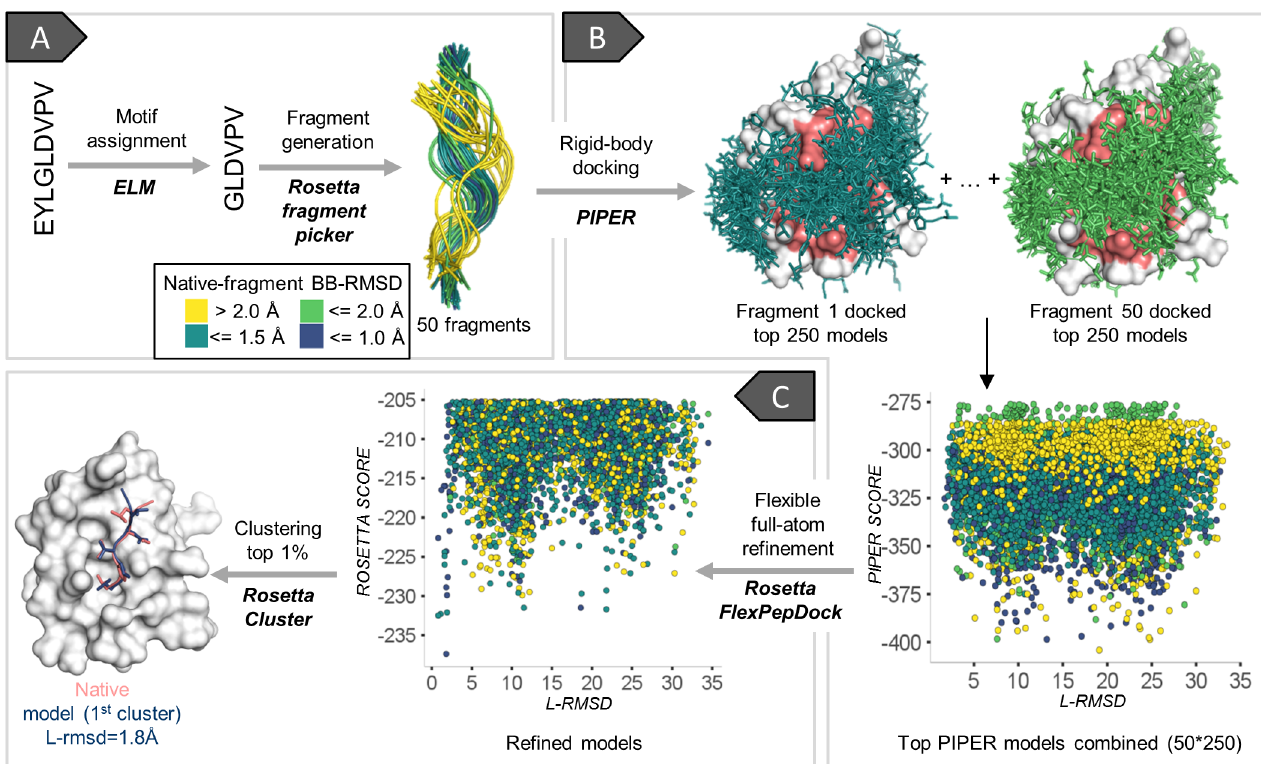
Fig 1. Overview of the PIPER-FlexPepDock peptide docking protocol. Example shown: PDZ domain-peptide interaction [PDB IDs of receptor structure 1MFG (bound) and 2H3L (free)]. For a given receptor structure and peptide sequence, the divide and conquer strategy involves first the description of the peptide as an ensemble of fragments (A) , their fast and exhaustive rigid body docking (using PIPER) onto the whole receptor (binding site region is shaded salmon) (B) , and subsequent high-resolution refinement (using Rosetta FlexPepDock; the top 5000 models are included in the plot) (C), followed by clustering and selection of top ranking representatives. Fragments are colored according to their similarity to the native bound peptide conformation. L-RMSD: Ligand root mean square deviation from crystal structure; see text for more